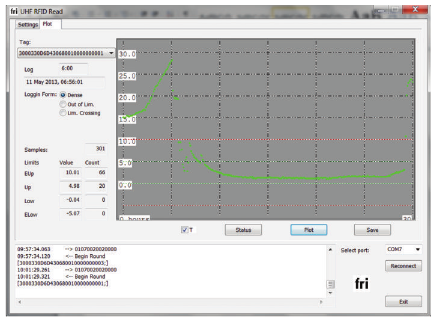
Figure 10: RFID-TL